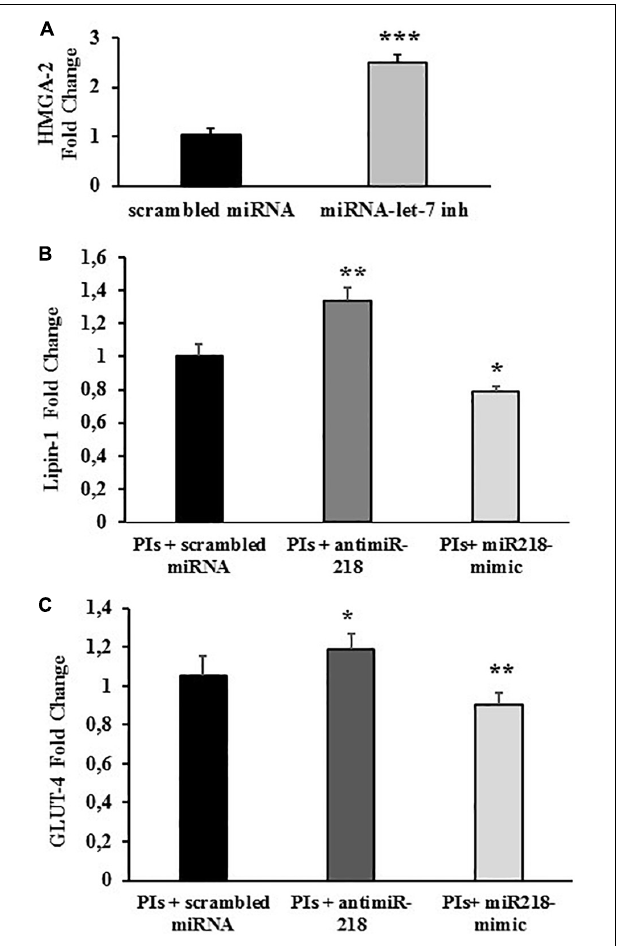
FIGURE 3 | Effect of LPV:RTV treatment on lipin-1 and GLUT-4 mRNA expression and miRNA-218 levels. Fully differentiated 3T3-L1 cells were treated as indicated in the legend of Figure 1 levels of lipin-1 mRNA (A) , miRNA-218 (B) and GLUT-4 mRNA (C) were measured by real-time PCR. Levels of lipin-1 and GLUT-4 mRNA were normalized by those of β -actin; miRNA-218-5p levels were normalized using U6 levels. Values are the mean ± SEM of 18 determinations per group obtained in three independent experiments. ∗ p < 0.05, ∗∗ p < 0.01, and ∗∗∗ p < 0.001 vs. vehicle.